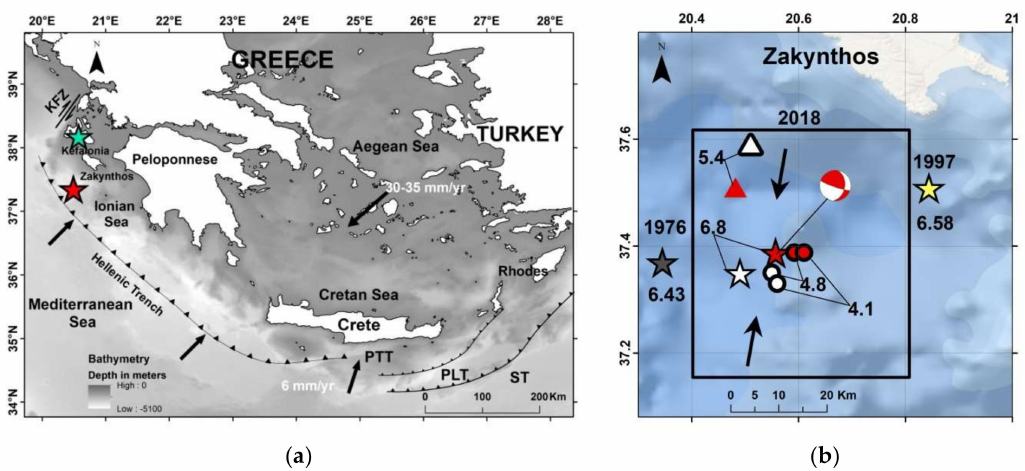
Figure1. ElementsoftheHellenicSubductionZone(HSZ)( a ); arrowsandnearbyfiguresshowdirections and velocities of lithospheric plates motion, respectively; toothed lines remark tectonic trenches along the HSZ; PTT = Ptolemy trench, PT = Pliny trench; ST = Strabo trench, KFZ = Kefalonia Fault Zone. Red and green stars illustrate relocated epicenters of the 25 October 2018 M w = 6.8 earthquake (this paper) and the 26 January 2014 M w = 6.0 earthquake (see text). Main events of the 2018 earthquake sequence and of past seismicity ( b ); within the inset are epicenters of the 25 October 2018 mainshock (star), of the largest imminent 17 and 25 October 2018 foreshocks (circles) and of the largest 30 October 2018 aftershock (triangle). Open symbols are determinations from the National Observatory of Athens (NOA) catalogue, red symbols are epicenters relocated in this paper. Figures near epicenters show moment magnitudes. Epicenters and magnitudes of the 11 May 1976 and 18 November 1997 mainshocks are determined by ISC-GEM Global Instrumental Earthquake Catalogue (http: // doi.org / 10.31905 / D808B825). Beach-ball is the Global Centroid Moment Tensor Project fault-plane solution (https: // www.globalcmt.org / CMTsearch.html) and arrows show inferred plate